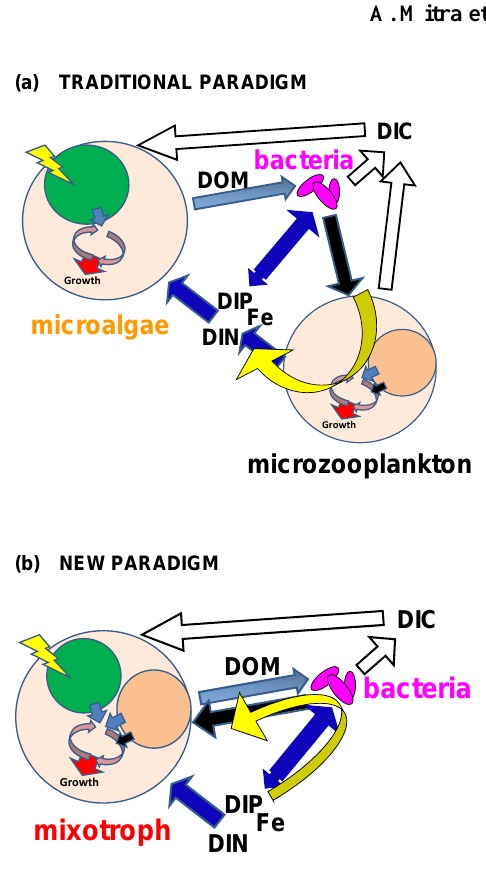
Fig. 6. Schematic showing the detailed involvement of bacteria and DOM for the supply of nutrients to support primary production (yel- low arrows) in the traditional paradigm (A) versus the new paradigm (B) . See Sect. 4.2. Black arrows indicate predatory